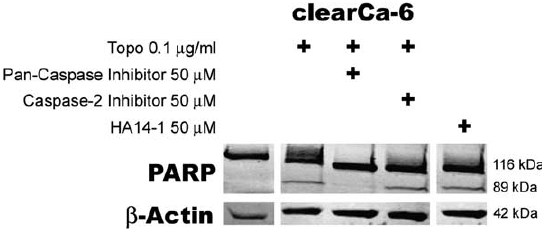
Fig. 6. Inhibition of caspase-2 does not prevent Topotecan-induced PARP cleavage. In the sensitive cell line clearCa-6 Topotecan treat- ment (0.1 µg/ml) for 12 h resulted in PARP-cleavage. Pretreat- ment with a Pan-caspase-inhibitor (50 µM) for 2 h followed by a cotreatment of the cells with Topotecan (0.1 µg/ml) and the Pan-caspase-inhibitor (50 µM) prevented PARP cleavage. Pretreat- ment with a specific caspase-2-inhibitor (50 µM) for 2 h followed by a cotreatment of the cells with Topotecan (0.1 µg/ml) and the caspase-2-inhibitor (50 µM) could not prevent PARP cleavage as a marker of